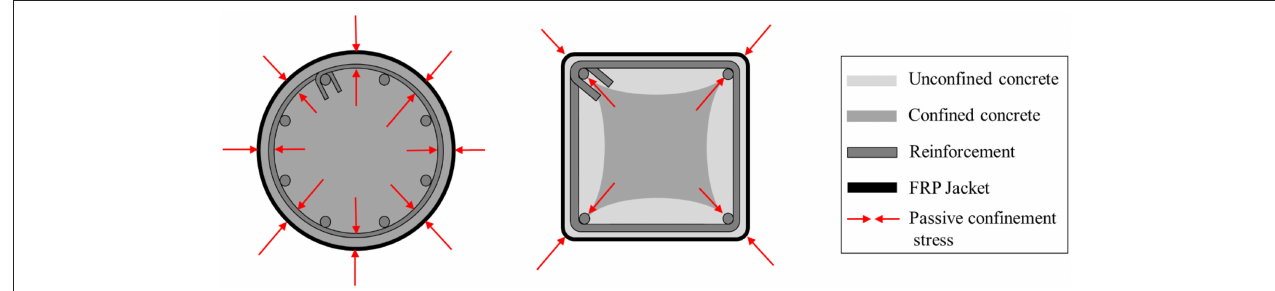
FIGURE 1 | Confining mechanisms for circular and rectangular